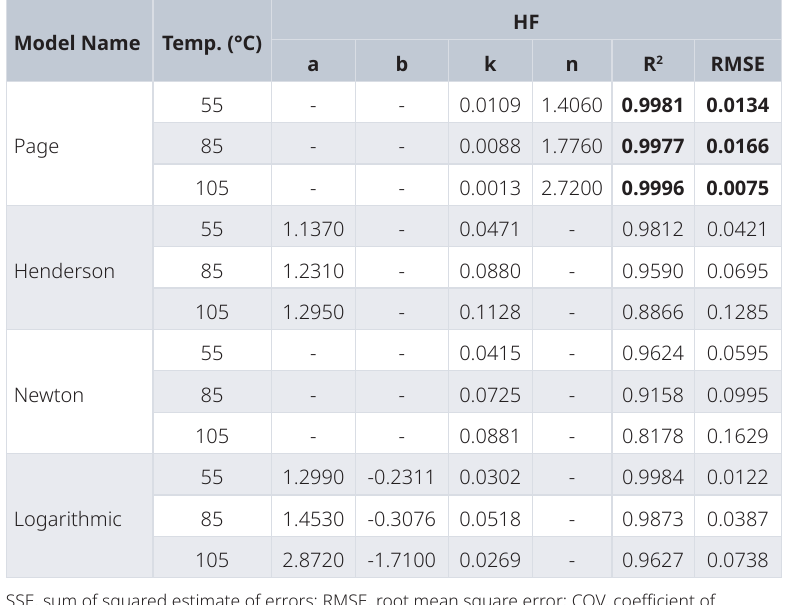
Table 4. Statistical data for isothermal drying of human faeces (HF).